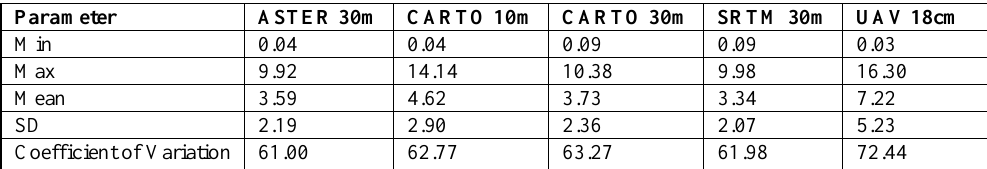
Table 4: LS factor statistics with multiple flow